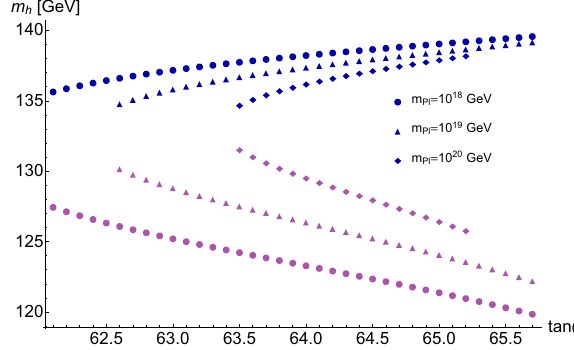
Fig. 9 MassesofSM-likeCP-evenscalarHiggsboson,for M 12 = 380 GeV and fixed point condition set at different scales of 10 18 (circles), 10 19 (triangles), and 10 20 (diamonds) GeV. The upper (blue) branches correspond to the vacuum-stable solutions, the lower (purple) branches to the vacuum-unstable ones